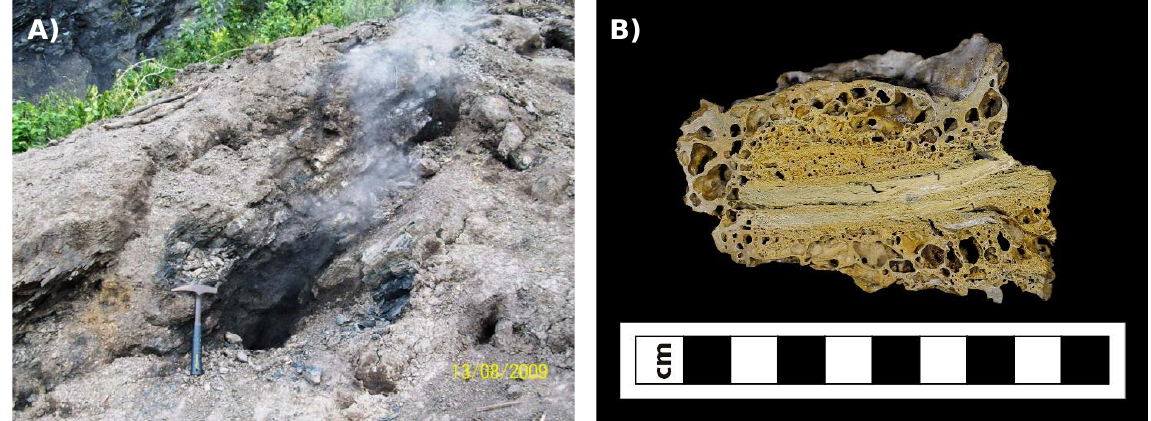
Figure 12. Photographic record of spontaneous ignition ( A ) due to low-temperature oxidation in Kip mudstone from Loma Alta, emitting toxic gases; ( B ) charred hand sample (clinker), with very high porosity and permeability generated by the combustion and pyrolysis processes of hydrogen sulfide and macerals within the rock.